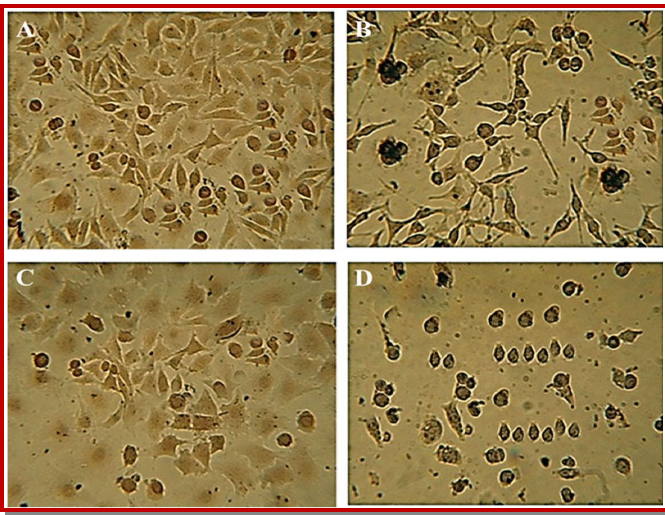
Figure 3: Effects of corosolic acid on the morphology of CaSki cervical cancer cells. Morphological changes were observed under the phase-contrast microscopy after treating without (A, control) and with 10 (B), 50 (C) and 100 μ M (D) of corosolic acid for 48